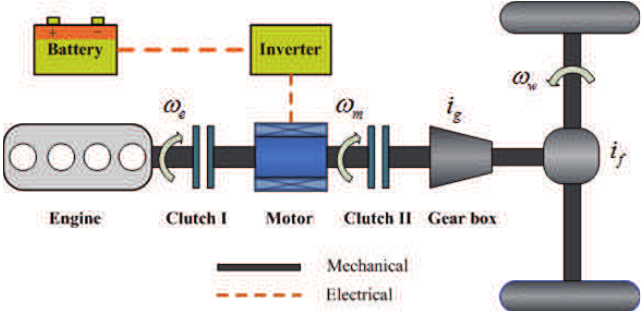
Figure 1. Architecture of the parallel hybrid electric